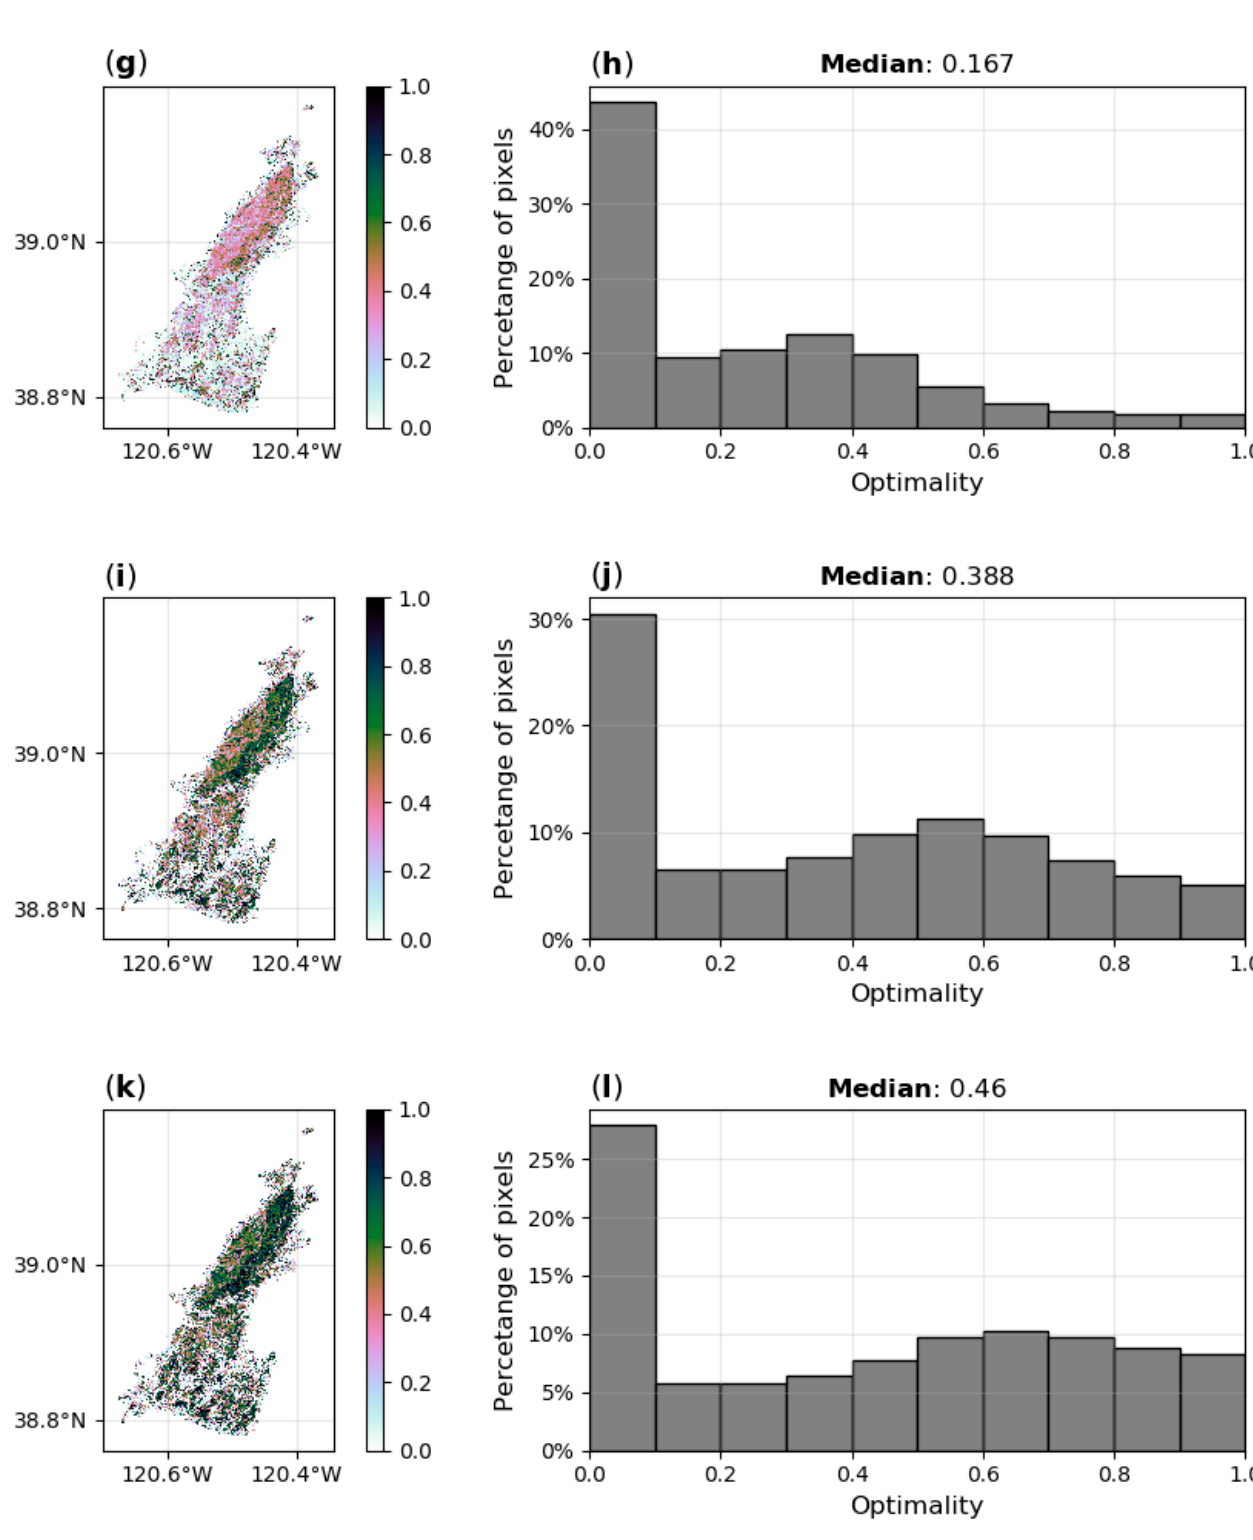
Figure 6. Optimality maps and histograms of the differenced normalized burn ratio (dNBR) indices for the King fire. ( a ) Optimality map dNBR 1 ; ( b ) Optimality map dNBR 2 ; ( c ) Optimality map dNBR 3 ; ( d ) Histogram of the dNBR 1 ; ( e ) Histo-gram of the dNBR 2 ; ( f ) Histogram of the dNBR 3 . Optimality maps and histograms of the differenced normalized difference vegetation index with mid infrared (dNDVI MID ) indices for the King fire. ( g ) Optimality map dNDVI MID,1 ; ( h ) Optimality map dNDVI MID,2 ; ( i ) Optimality map dNDVI MID,3 ; ( j ) Histogram of the dNDVI MID,1 ; ( k ) Histogram of the dNDVI MID,2 ; ( l ) Histogram of the dNDVI MID,3